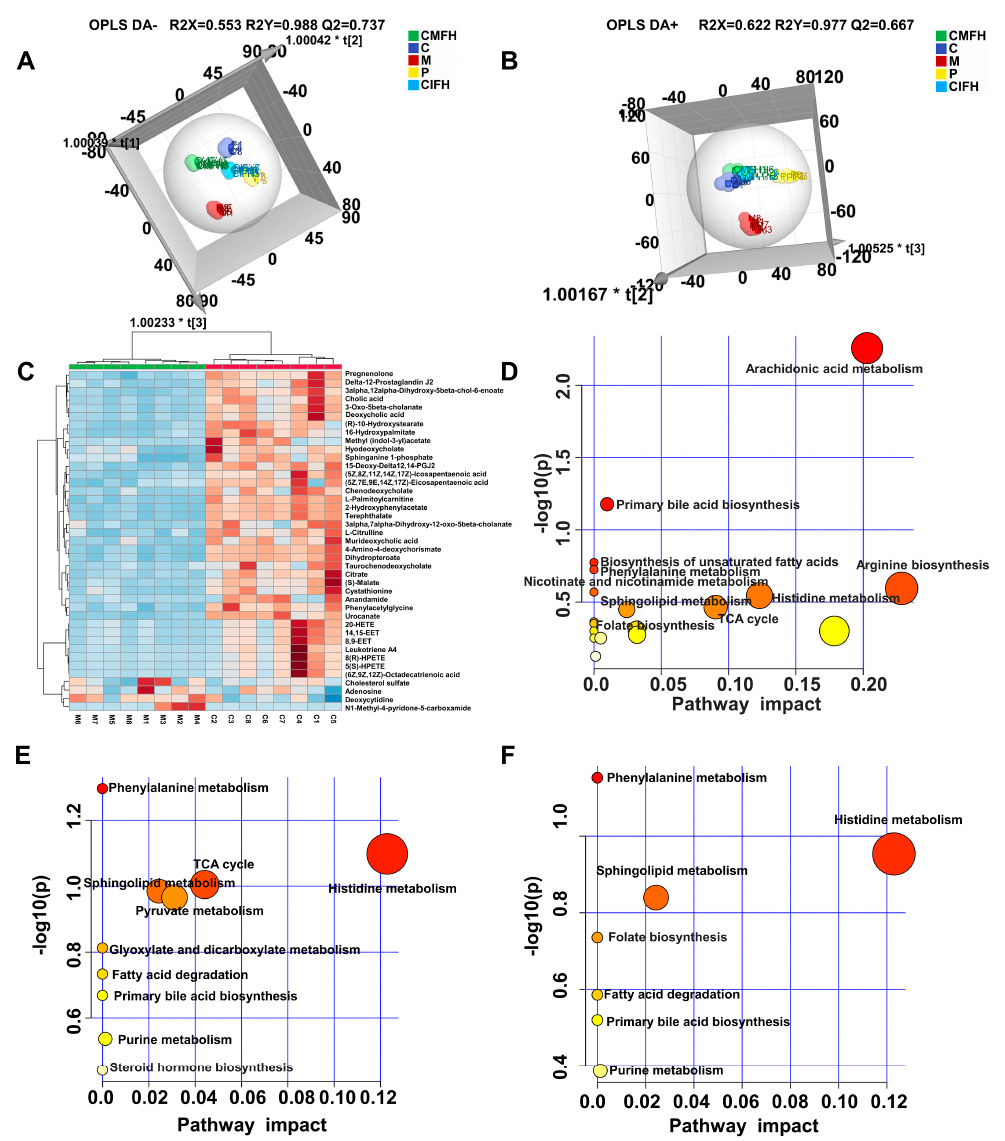
Figure 9. Non-targeted metabolomics investigation of rat plasma samples. ( A , B )—OPLS − DA score charts under negative and positive scan modes of C, M, P, CMFH, and CIFH groups; ( C )—Heat map of differential biomarkers between the C and M groups; ( D )—Pathway analysis of differential biomarkers between the C and M groups; ( E , F )—Pathway analysis of biomarkers called back in CMF and CIF groups, respectively.